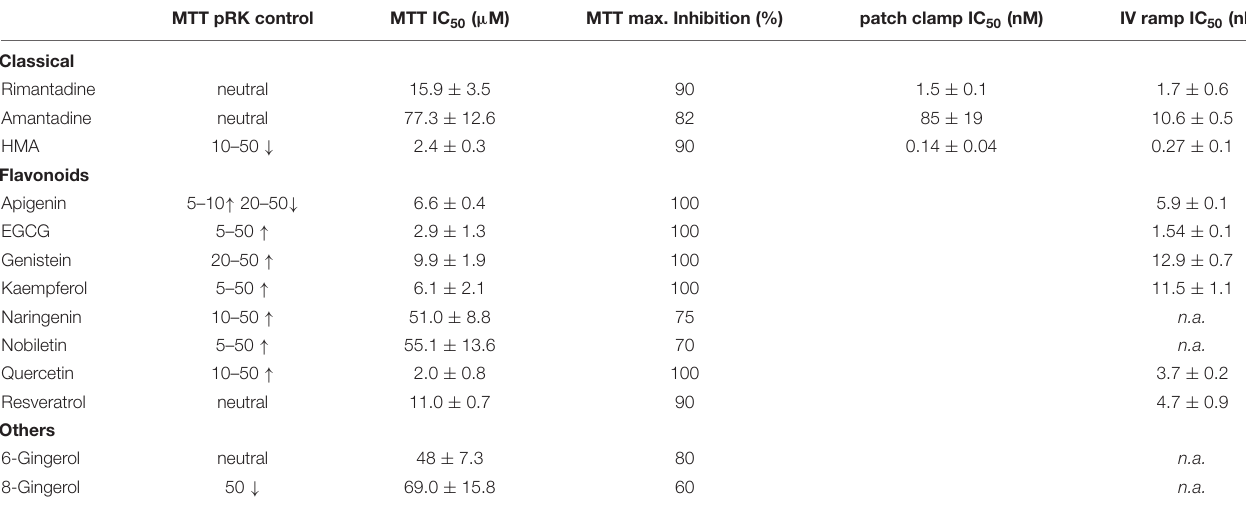
TABLE 1 | Inhibition of SARS-CoV E protein by classical viroporin inhibitors and